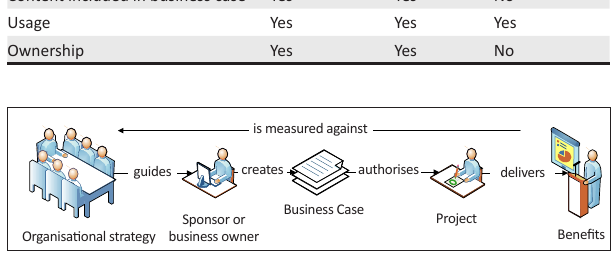
FIGURE 3: Theoretical framework for the business case information